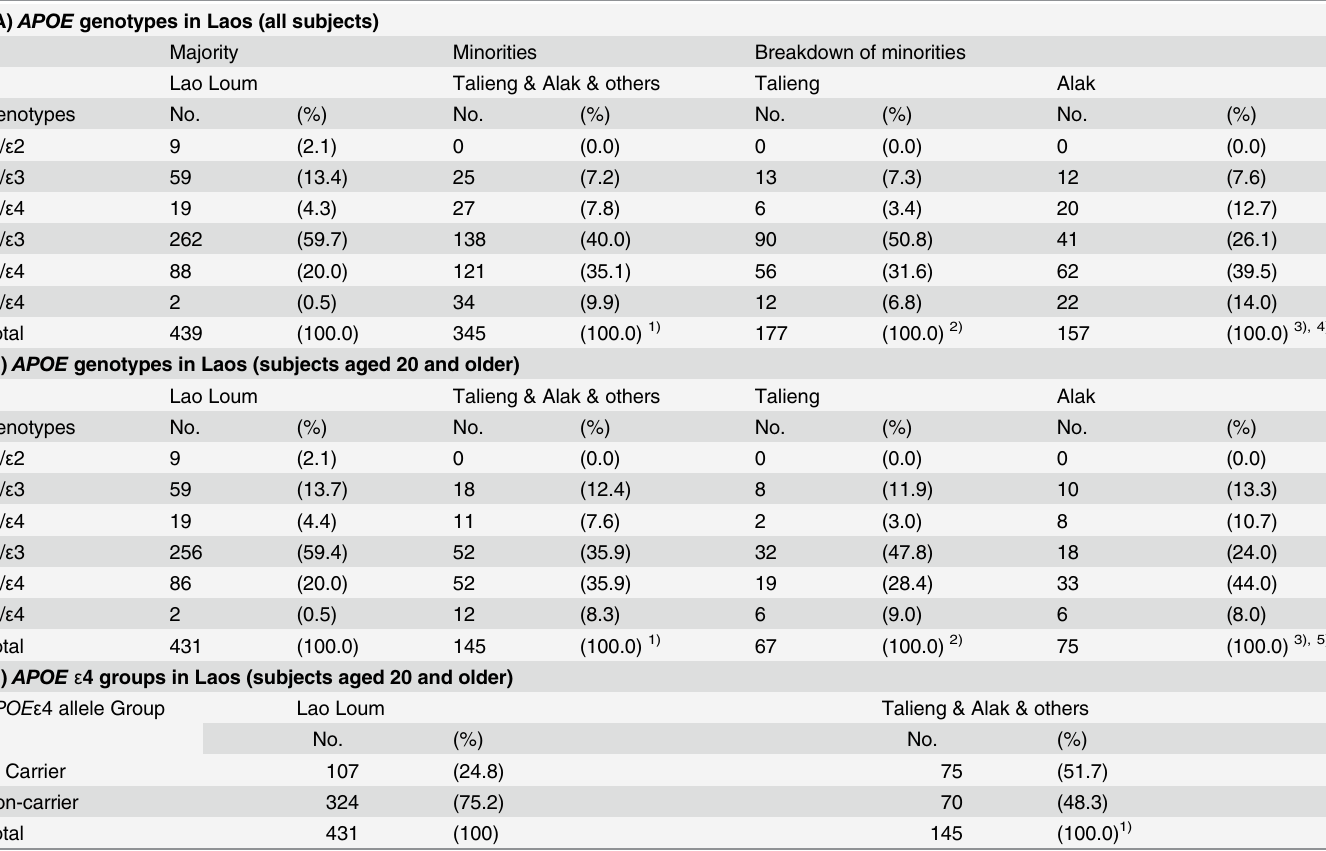
Table 2. Genotype distribution of the APOE polymorphism in